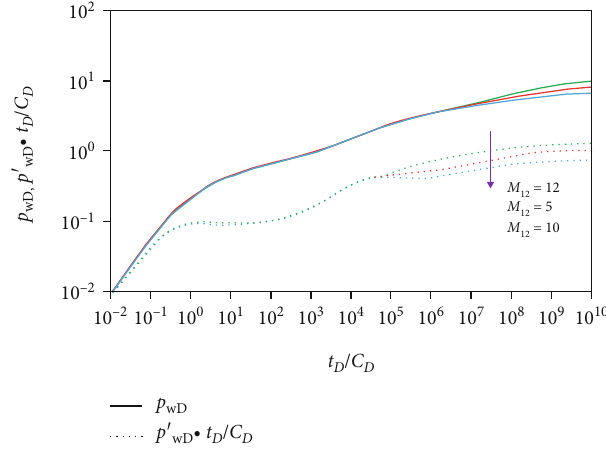
Figure 7: In fl uence of permeability ratio on typical pressure